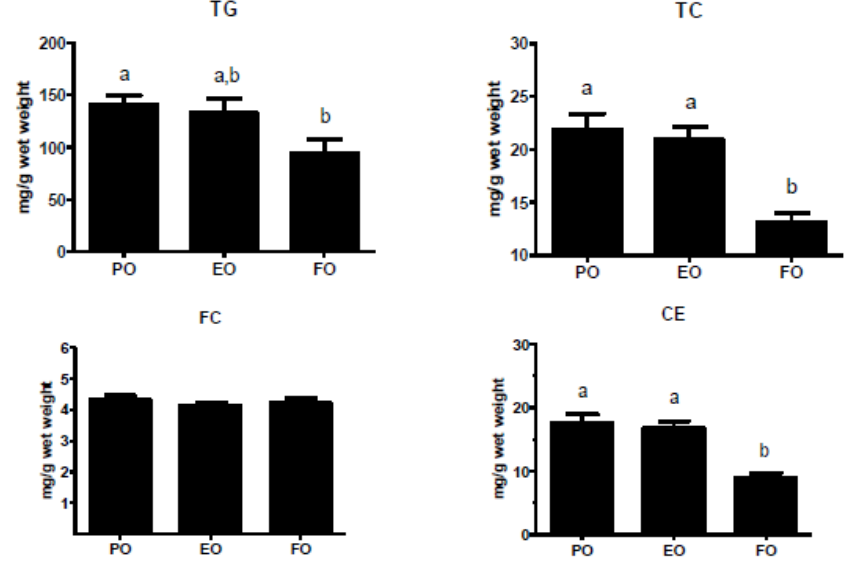
Figure 3. Liver lipid content. Mice were fed experimental diets containing PO, EO, or FO for 16 weeks before livers were harvested, lipids extracted, and lipid content was measured using enzymatic assays. The bars represent mean ± S.E.M. for PO ( n = 16), EO ( n = 13), and FO ( n = 12). Values with different letters are significantly different ( p < 0.05). TG,